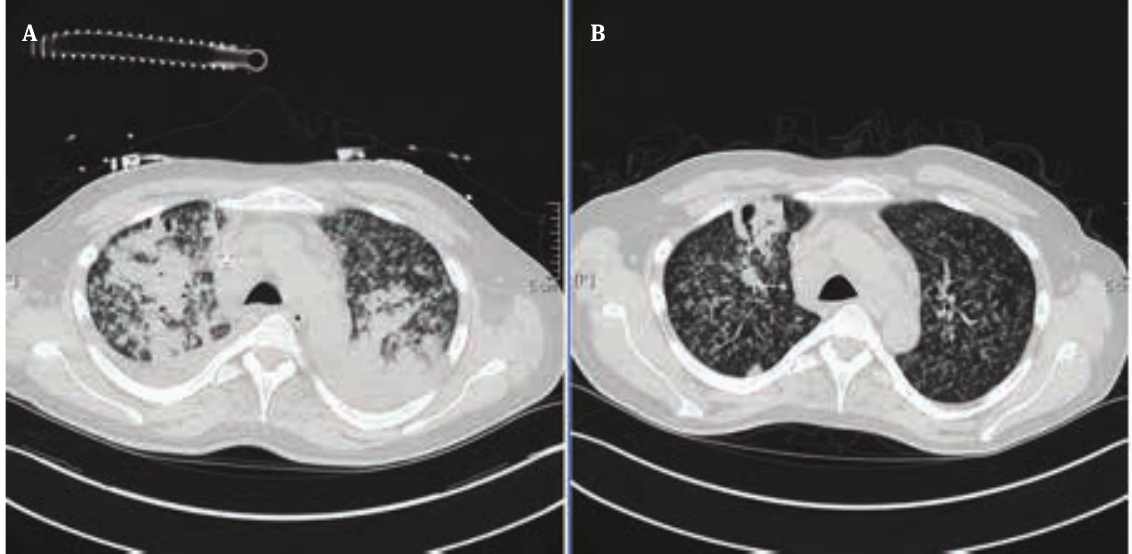
Figure 3: A Contrast enhanced scan showed severe bilateral pulmonary infiltrates. B: Contrast enhanced scan revealed regressive pulmonary infiltrates on both sides after the first course of 2 weeks tuberculosis treatment.